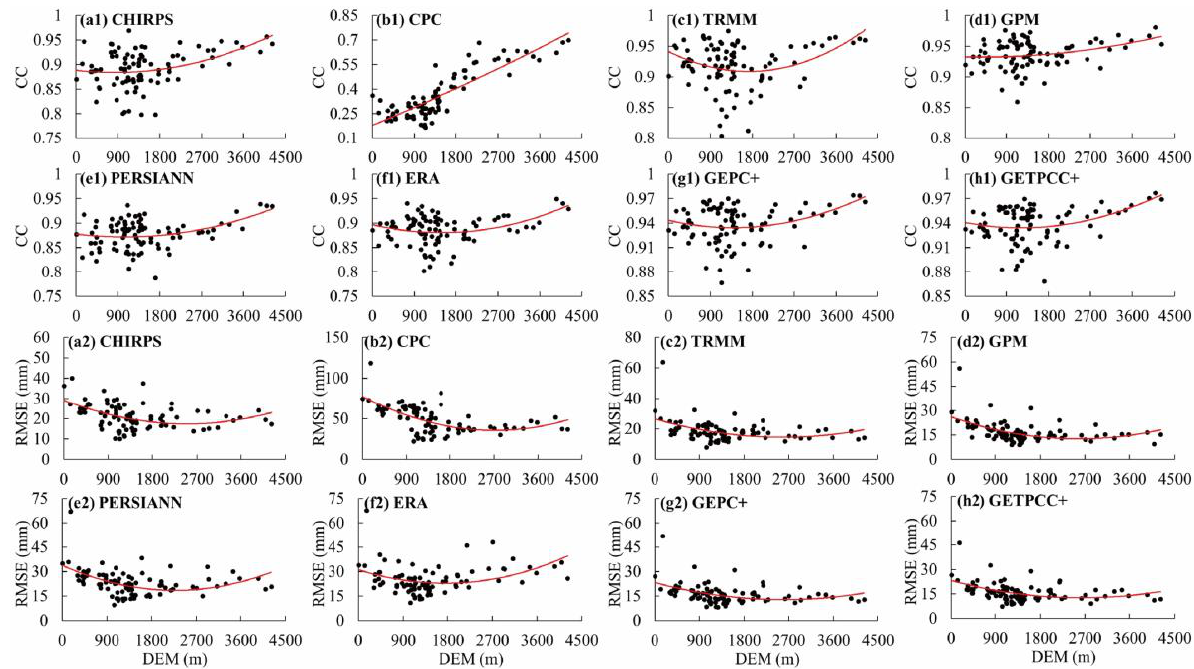
Figure 7. Monthly precipitation scatter density for observations and simulations of eight precipitation products for the YRB and subbasin. The legend color represents the probability density estimated using the Gaussian kernel. ( a1 – h1 ) is the CC corresponding to different elevations of eight precipitation products. ( a2 – h2 ) is the RMSE corresponding to different elevations of eight precipitation products.